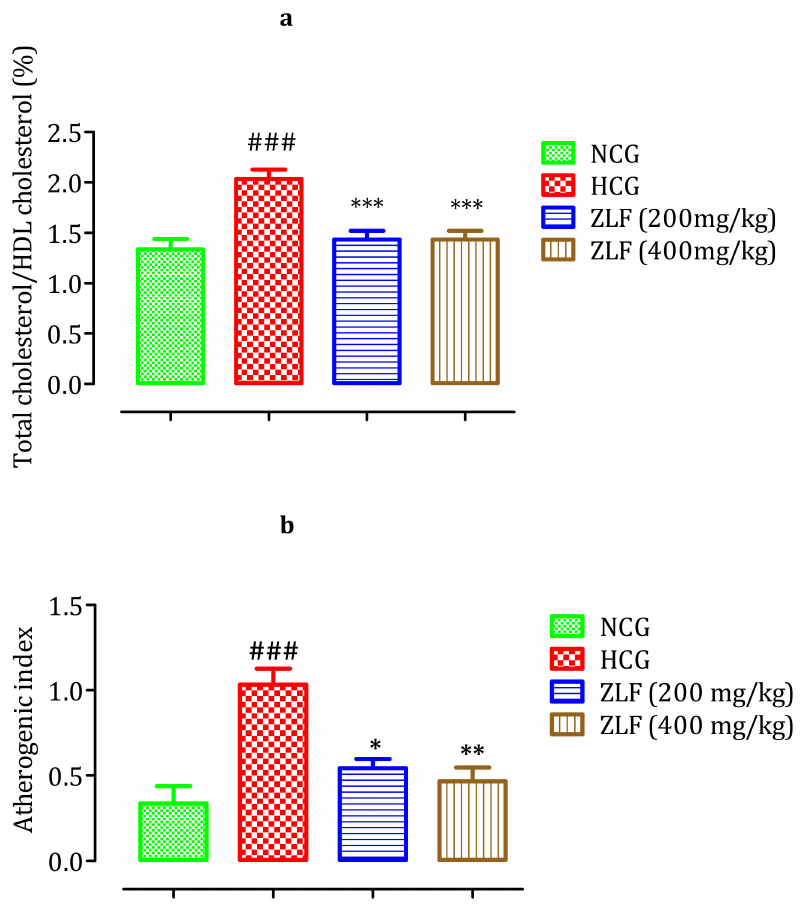
Figure 5. Effect of the aqueous ZLF extract on the ratio of total cholesterol/HDL-cholesterol ( a ) and Atherogenic index ( b ) in mice exposed to HFD. Data are mean ± SEM, n = 6. ### p ≤ 0.001 versus NCG. * p < 0.05, ** p < 0.01, *** p < 0.001 versus HFD group. ns: not